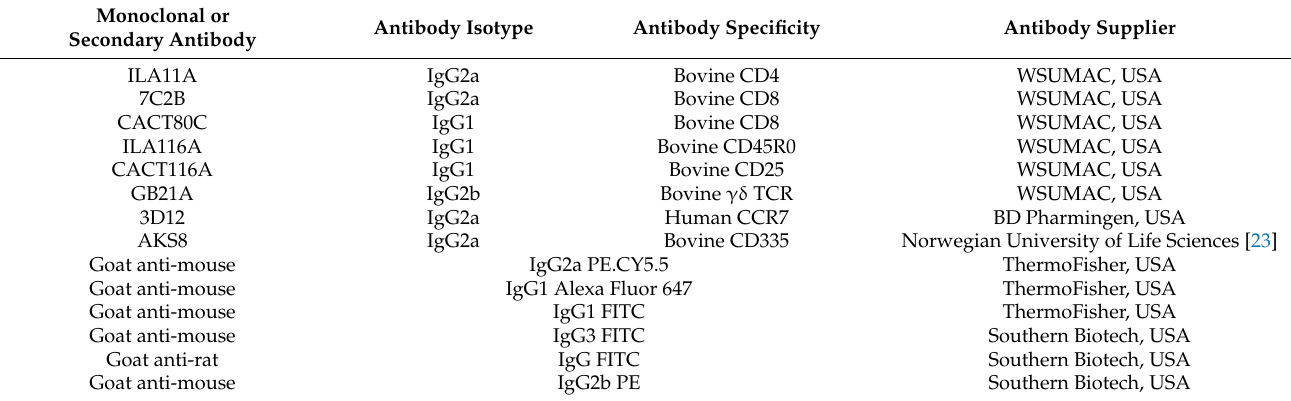
Table 1. List of monoclonal and secondary antibodies used in the present study. Monoclonal or Antibody Isotype Antibody Secondary Antibody